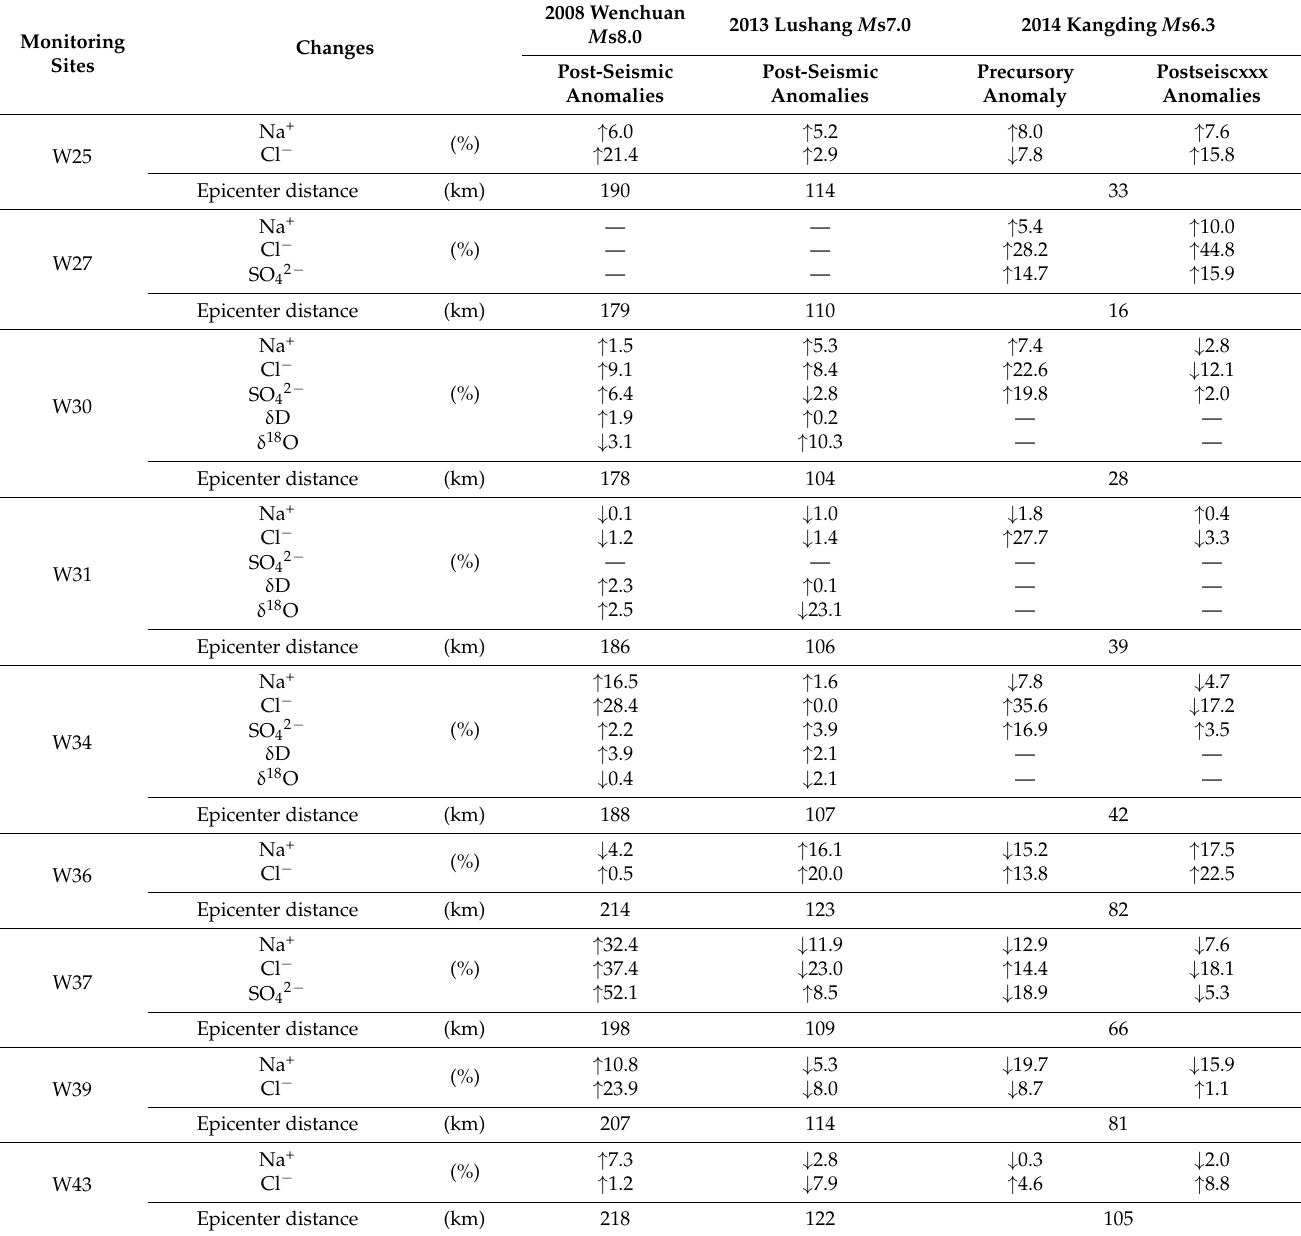
Table 4. The occurrence time of precursory and post-seismic anomalies in the continuous monitoring sites before three